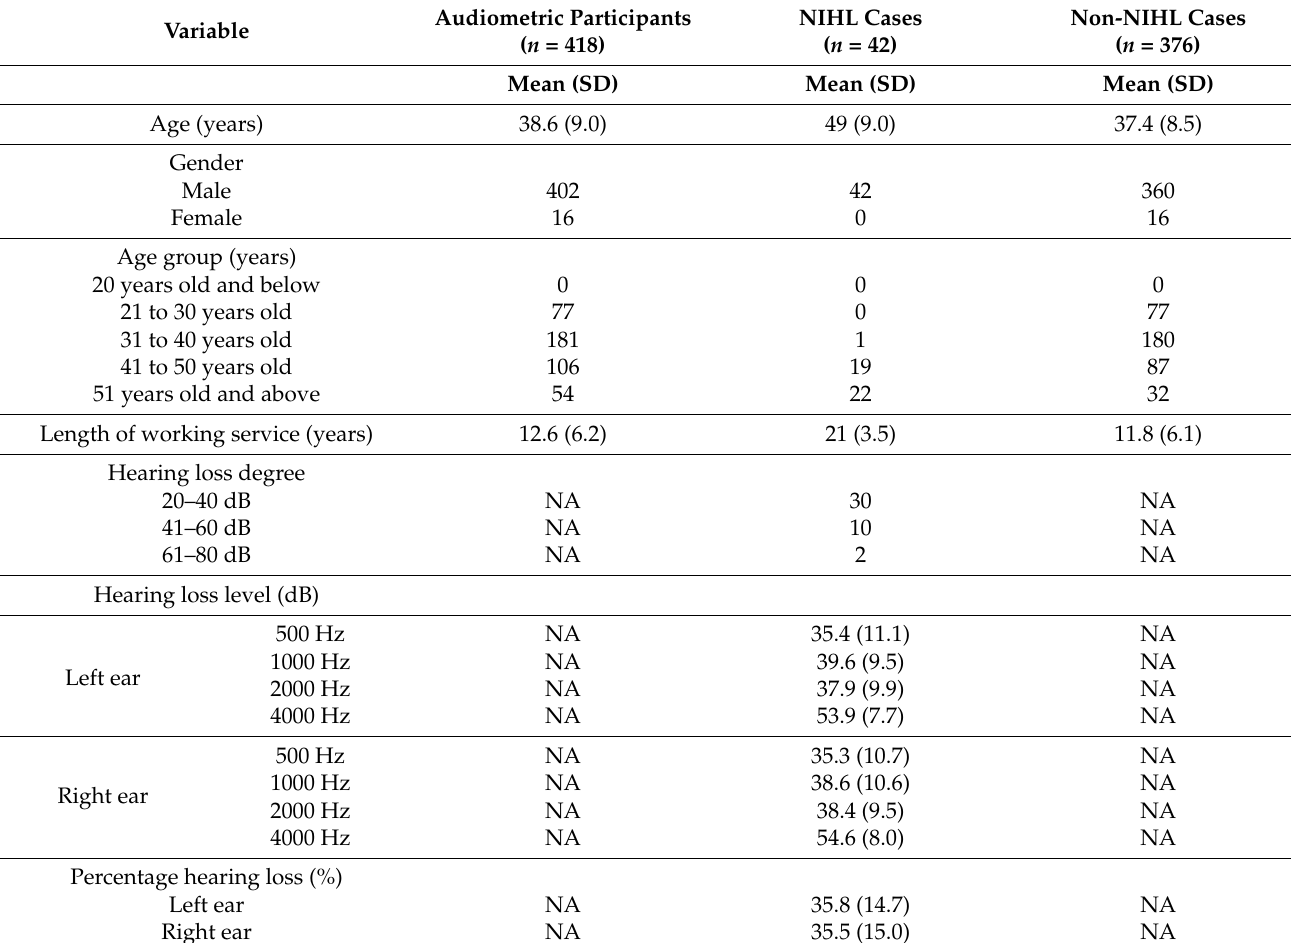
Table 4. The Characteristics of NIHL and Non-NIHL Cases at Study